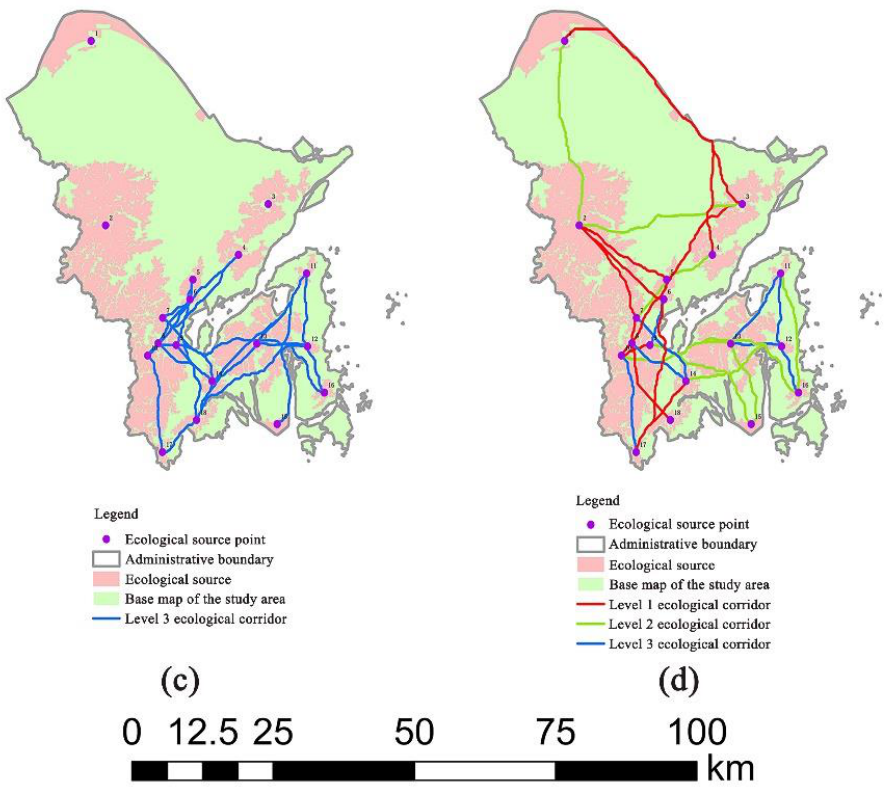
Figure 8. Ecological security pattern of Ningbo City: ( a ) primary level 1 ecological corridor; ( b ) pri- mary level 2 ecological corridor; ( c ) primary level 3 ecological corridor; ( d ) optimized ecological security pattern.